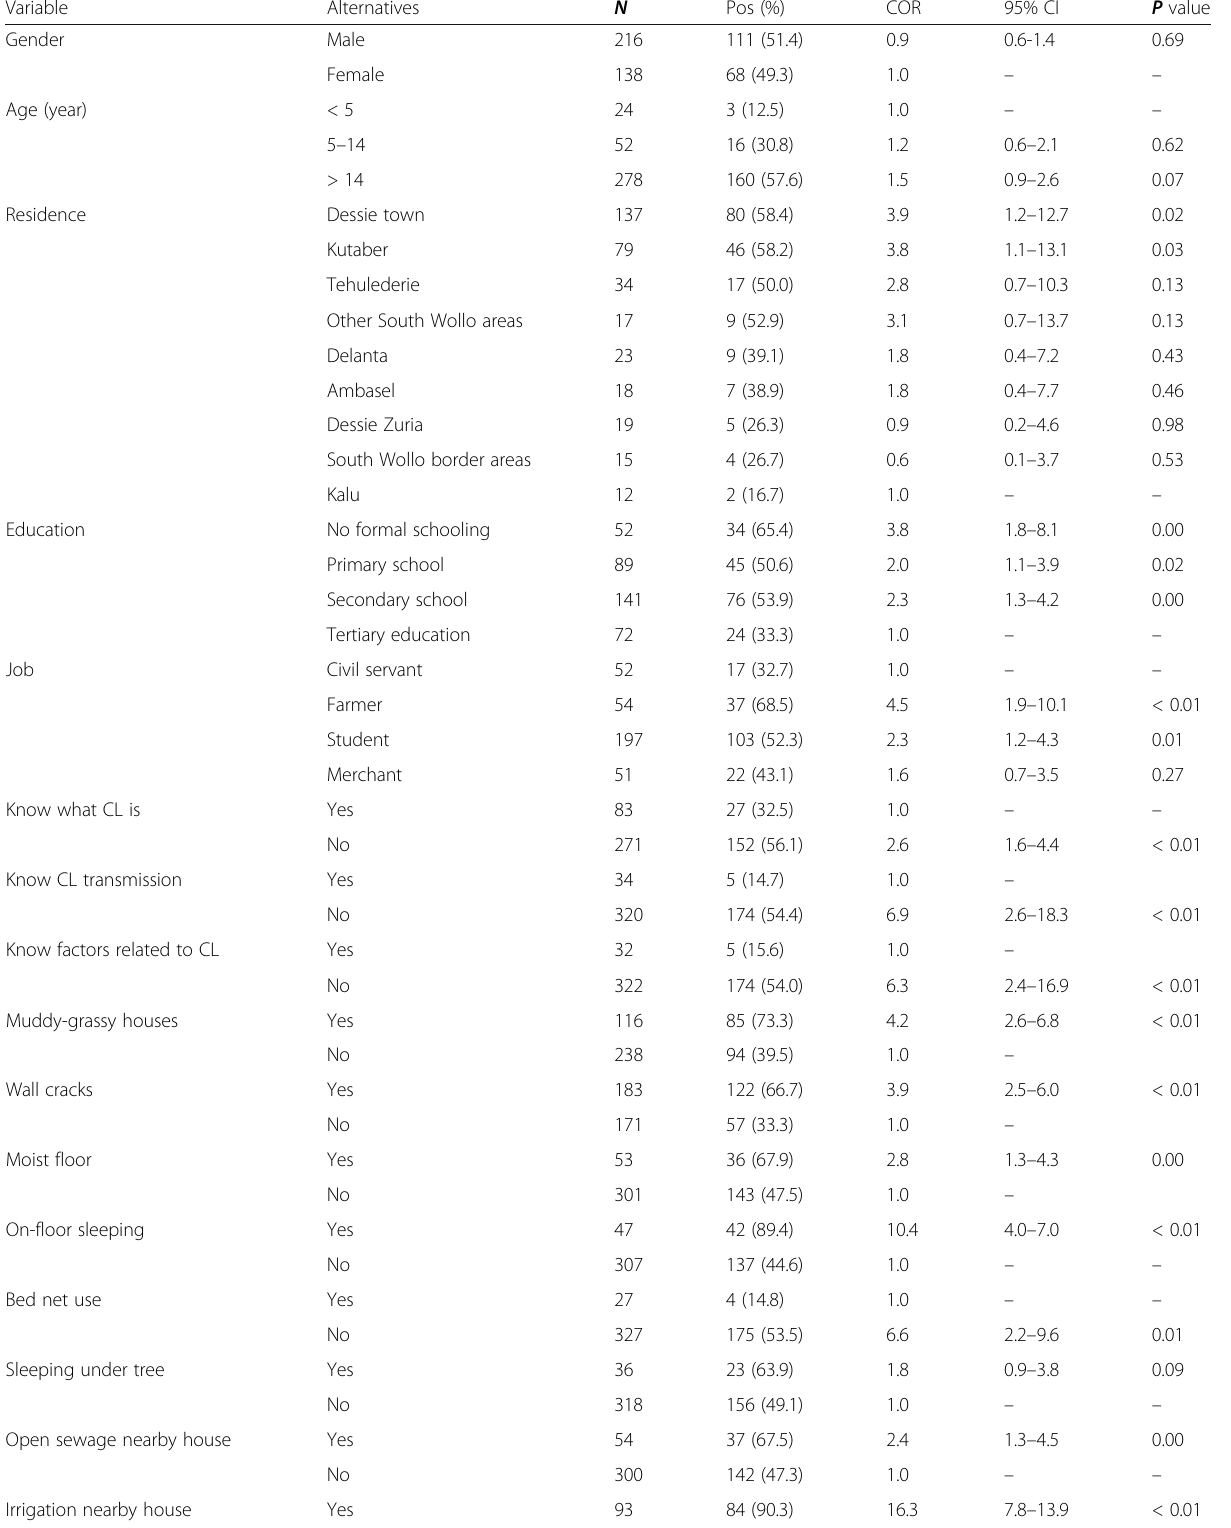
Table 4 Univariable logistic regression analysis of potential determinants in relation to CL positivity at BMH, Dessie town,